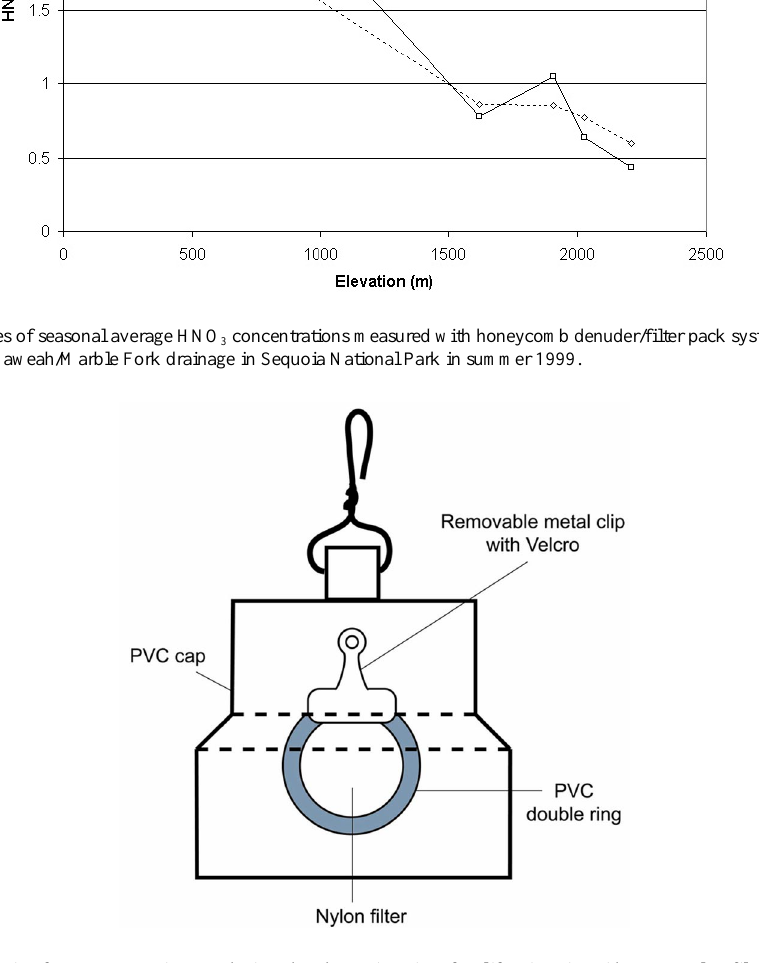
FIGURE 4. Schematic of HNO 3 protective cap designed at the University of California, Riverside. Two nylon filters enclosed in PVC double rings were inserted in metal clips that were attached to the cap’s inner wall with Velcro